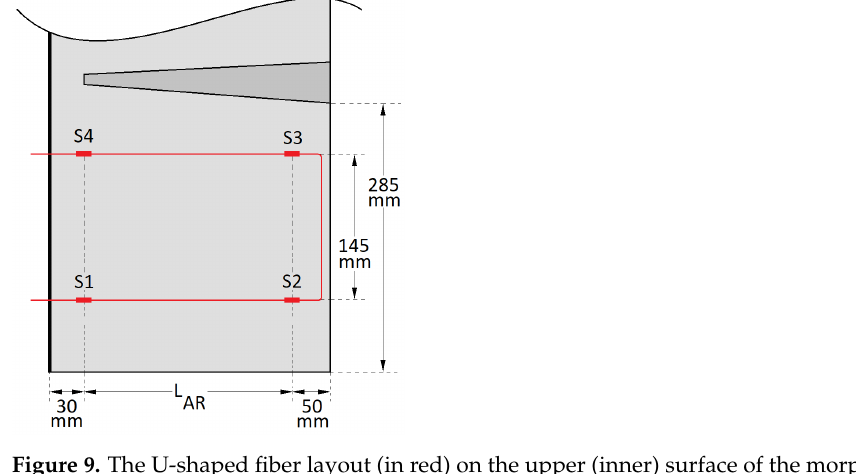
Figure 9. The U-shaped fiber layout (in red) on the upper (inner) surface of the morphing module. The location of FBG sensors (S1 to S4) along the fiber are as